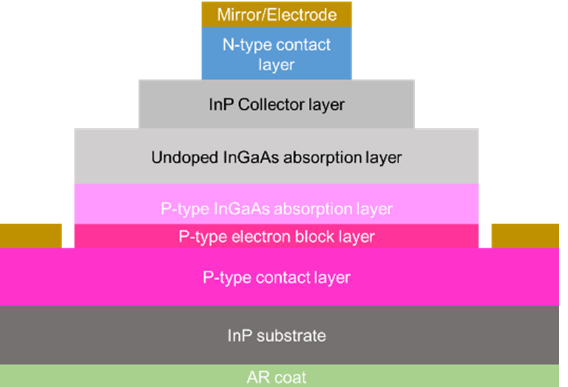
Figure 4. Schematic cross-section of one of our inverted p-down pin photodiodes